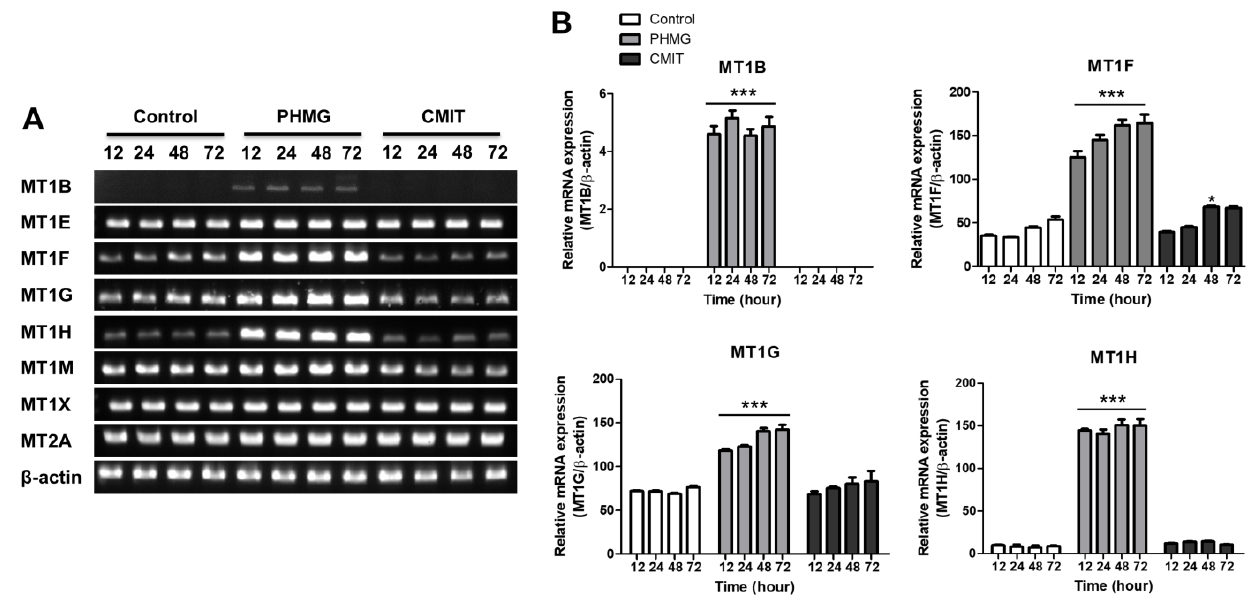
Figure 3. Effects of PHMG and CMIT on the mRNA expression of metallothionein-1 ( MT1 ) . ( A ) At various time points after exposure to 2 µ g/mL of PHMG and CMIT, the mRNA expression levels of MT1B, MT1E, MT1F, MT1G, MT1H, MT1M, MT1X, and MT2A were analyzed through reverse transcription-polymerase chain reaction (RT-PCR). ( B ) Quantitative analysis of mRNA expression. Statistically significant differences were analyzed by one-way analysis of variance (ANOVA; * p < 0.05 and *** p <